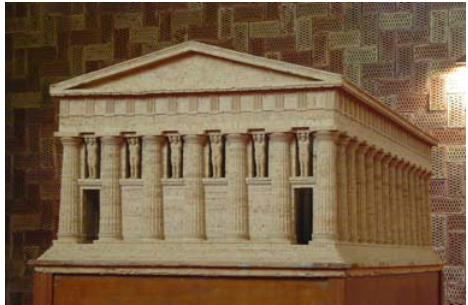
Figure 2. Ideal reconstruction of the Temple of Olympian Zeus